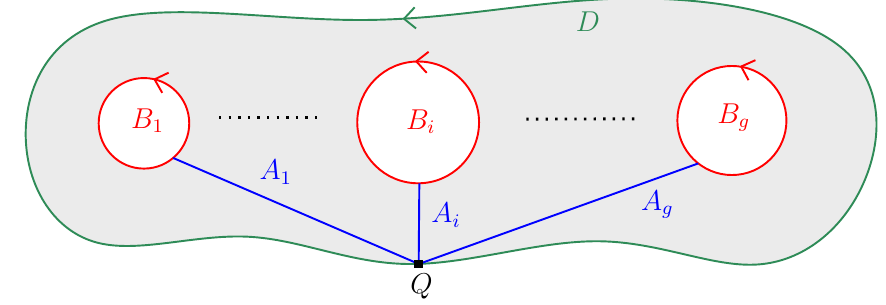
Figure 8. Resulting surface (annulus with g holes) after modding out by the Z 2 involution.